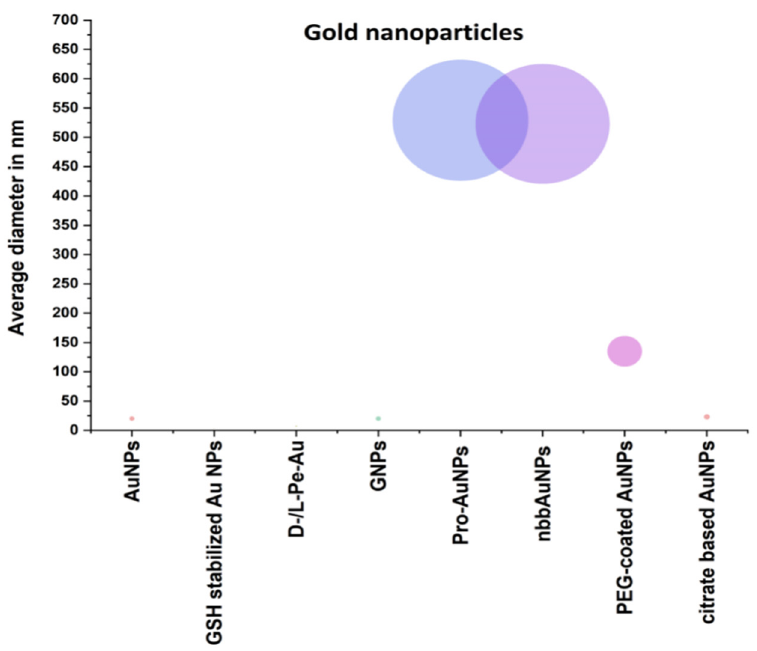
Figure 7. Different sizes of gold nanoparticles used in AD treatment.